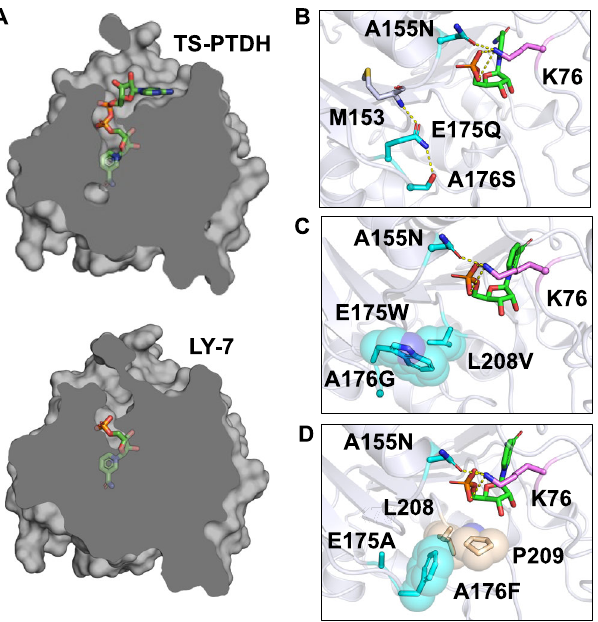
Fig. 3 | Structural modeling of PTDH variants discovered through growth selection with A155N template.A Cartoon of TS-PTDH depicting residue packing at the AMP binding pocket in LY-7. In TS-PTDH, NAD + is docked in the binding pocket. In LY-7, NMN + is docked in the binding pocket. B In LY-6 (A155N-E175Q- A176S), E175Q maintains similar steric properties of the originalglutamate, but the changefromthecarboxylicacidtoamideenablesE175Qtoactasahydrogenbond donor that bridges separate loops in the adenine binding cleft for improved sta- bility.ThebackboneamideofM153contactstheoxygenonE175Qandthehydroxyl from A176S accepts a hydrogen bond from the E175Q nitrogen. C LY-7 (A155N- E175W-A176G-L208V) is characterized by dense hydrophobic packing in the ade- nine cleft. A176G allows greater loop fl exibility and room for E175W to adopt a rotamer that occupies the open void where the adenine would typically fi t. L208V results in a slightly smaller side chain with greater shape complementarity to pack againstthebulkyE175W. D